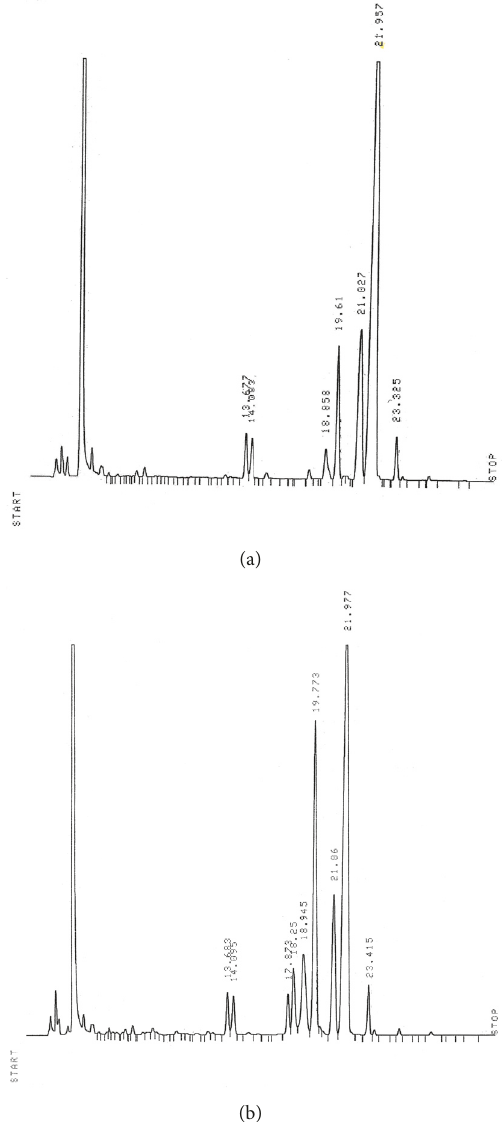
Figure 9: Chromatogram of the FA phenethyl esters in standard butter (a) and authentic Italian butter (b). Figure 10: Chromatogram of FA phenethyl esters in olive oil (a) and a mixture of olive and peanut oil (50 :50)